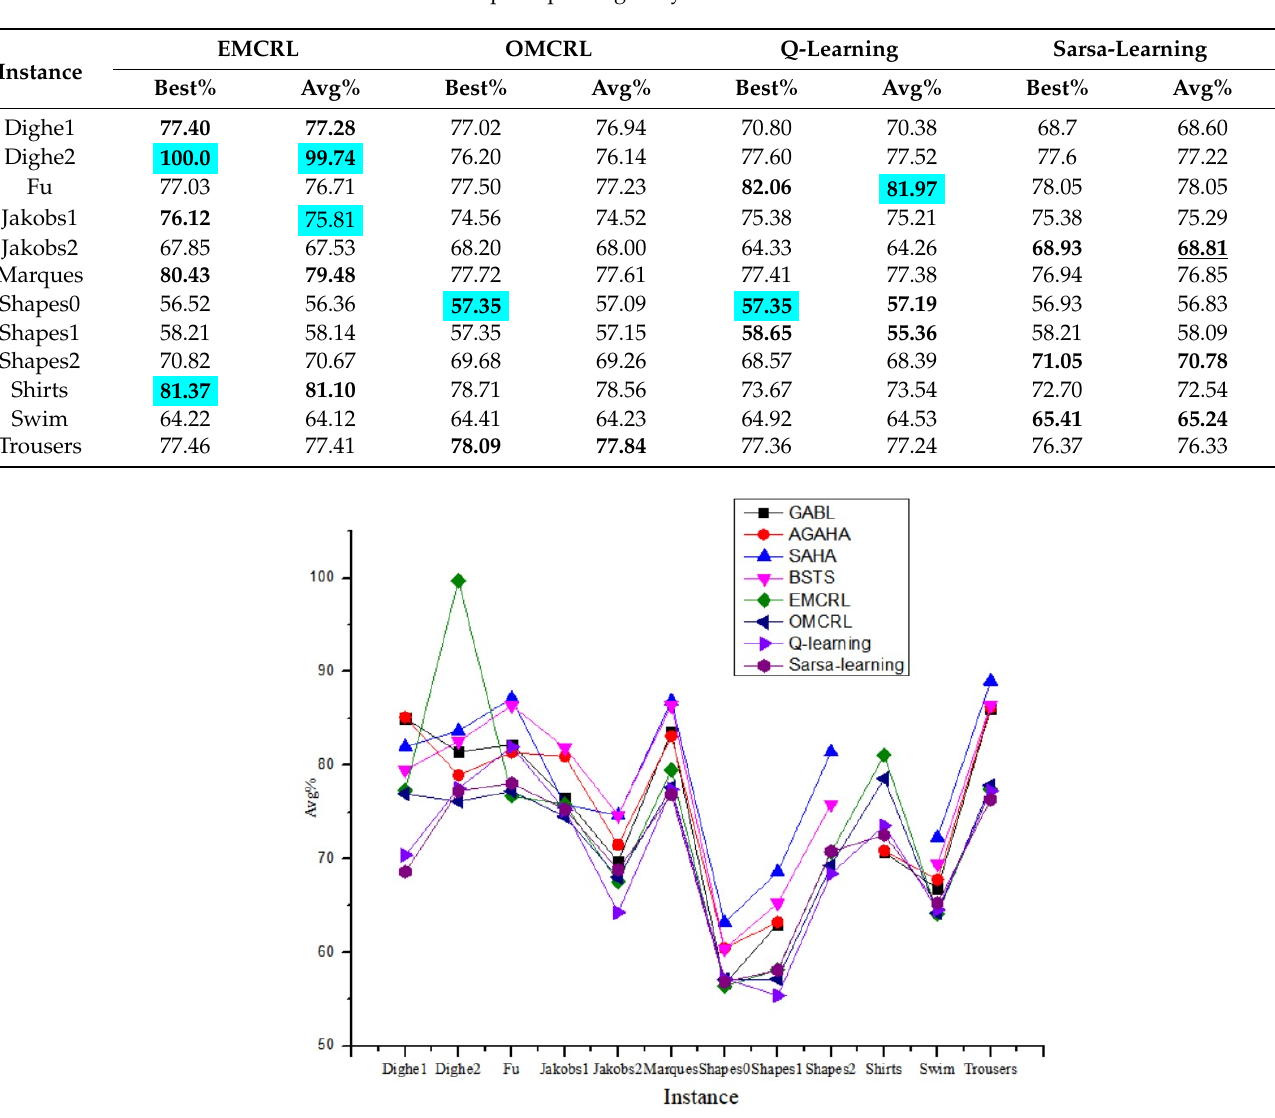
Figure 8. Average plate-utilization rate calculated using different algorithms for each instance.